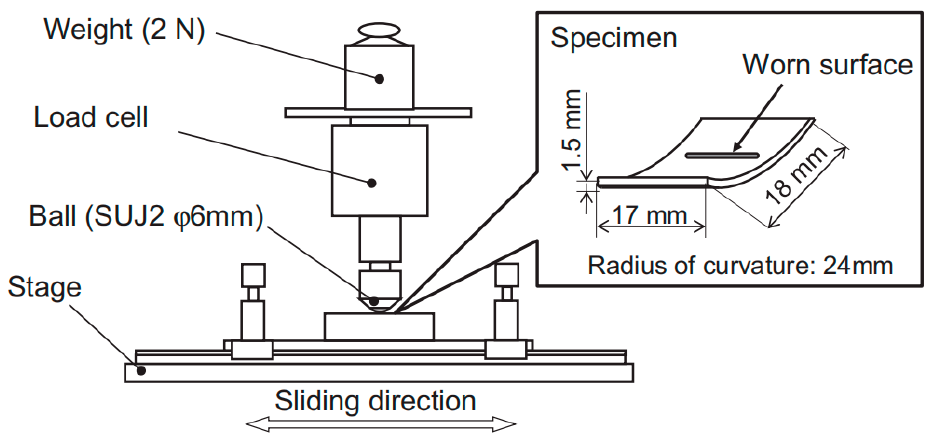
Figure 5. Schematic diagram of reciprocating friction and wear tester. Reprinted with permission from Ref. [13]. 2013, Elsevier.